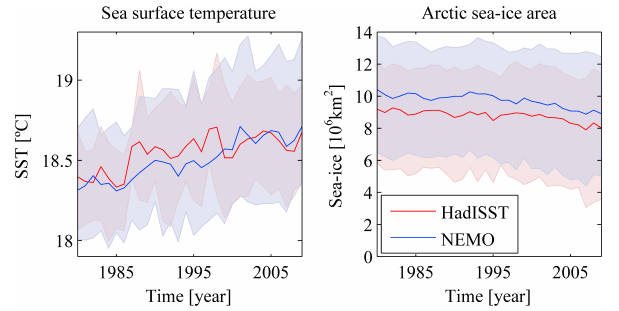
Fig. 3. The panels shows annual average (solid lines) and seasonal range (shaded regions) of sea surface temperature (left) and Arctic sea-ice area (right) for the HadISST climatology (red) and NEMO (blue).